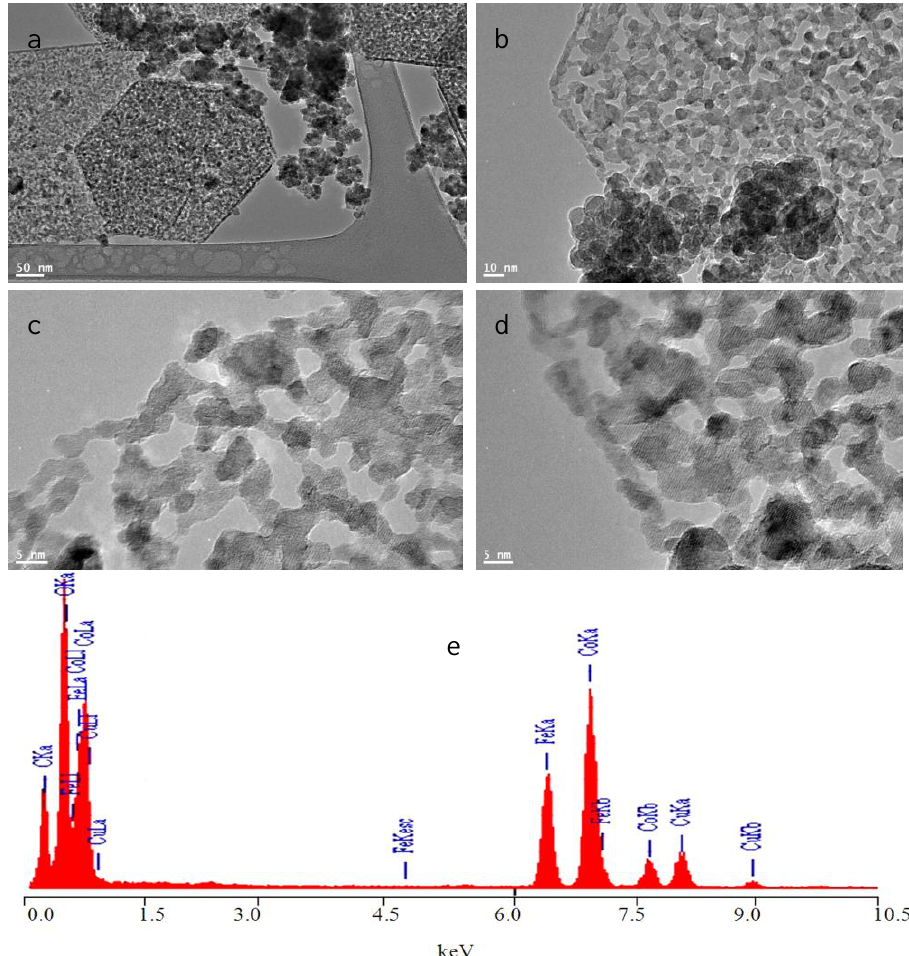
Figure 7. X-ray diffraction pattern of the CoFe 2 O 4 -supported Co-Fe LDH after thermal treatment.